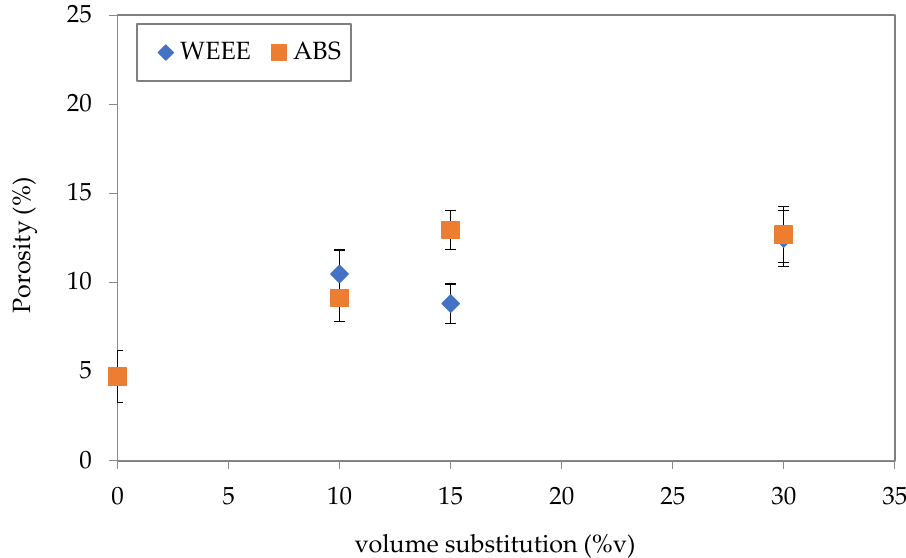
Figure 9. Porosity of mortar as a function of volume substitution.